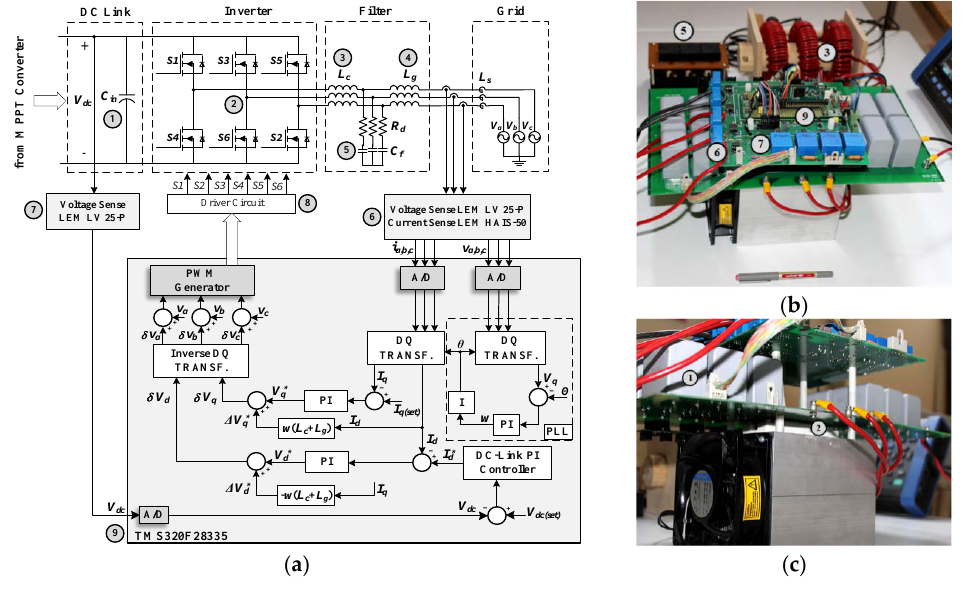
Figure 4. All SiC three-phase grid-connected two-level inverter: ( a ) power stage and its control circuitry; ( b ) top view of the developed hardware; and ( c ) side view. (1) Metal Film 12 × 40 μF Input Capacitor Bank (VISHAY MKP1848640094Y); (2) All-SiC Six-Pack Three-Phase Module (CREE CCS050M12CM2); (3,4) X-Flux L c = 250 μH and L g = 50 μH Filter Inductor (Magnetics 0078337A7); (5) Metal Film 15 μF Filter Capacitor (VISHAY MKP1848S61510JY5F); (6) Hall-Effect Current Transducer (LEM HAIS 50-P); (7) Voltage Transducer (LEM LV25-P); (8) Single Channel SiC MOSFET Driver (CREE CRD-001); (9) Experimenter Kit (TI TMDSDOCK28335).